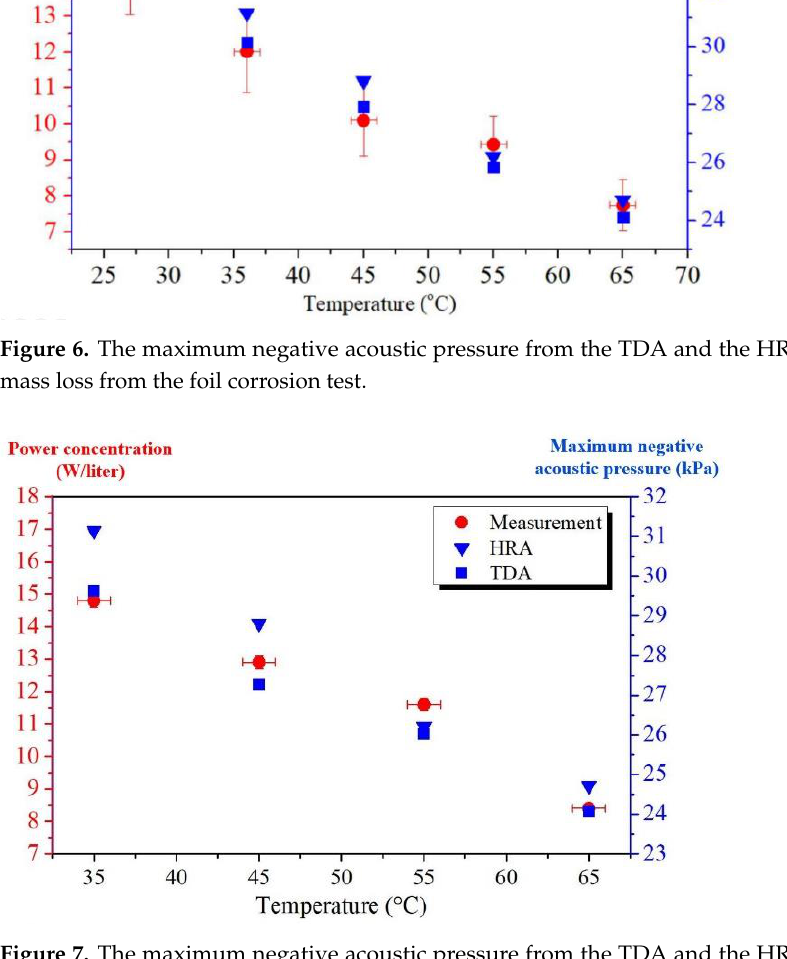
Figure 7. The maximum negative acoustic pressure from the TDA and the HRA compared to the power concentration from measurement.